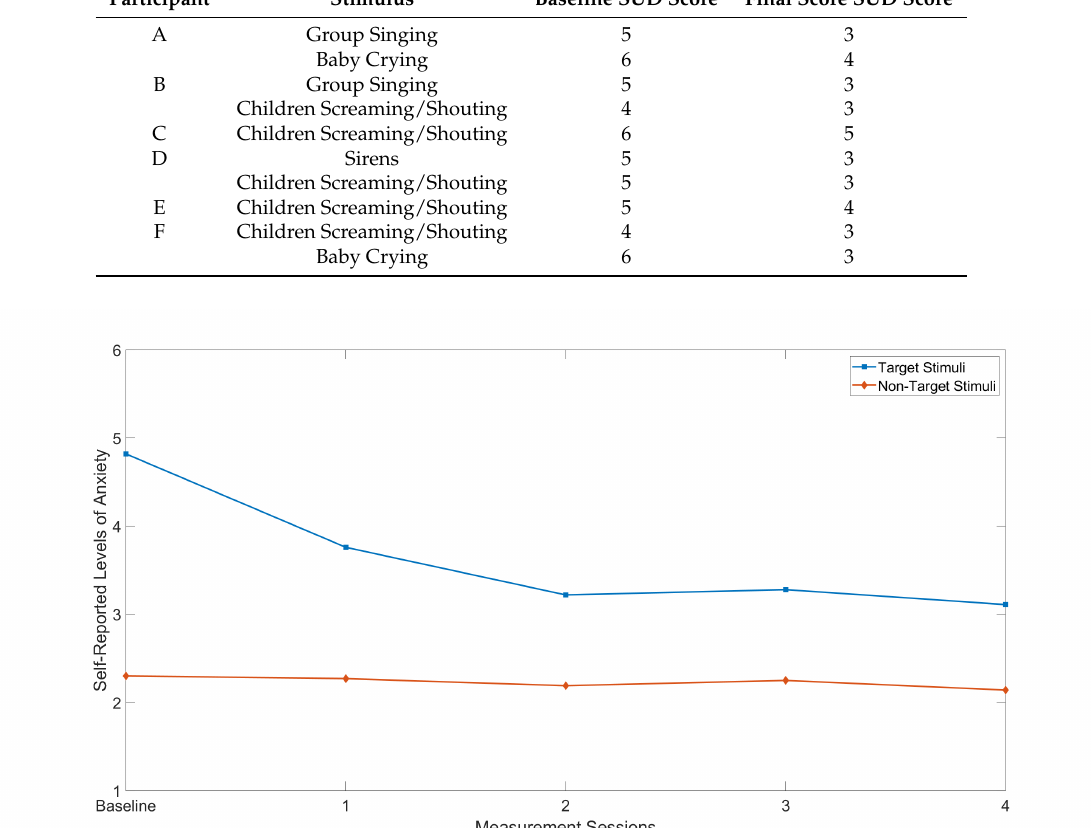
Figure 7. Calculated mean of all participants’ self-reported levels of anxiety for both target and nontarget auditory